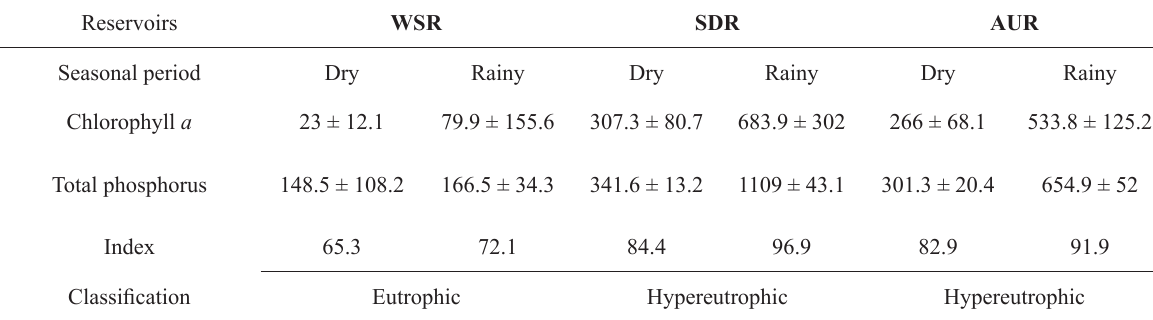
Index of the trophic state, regarding the values of chlorophyll a and total phosphorus, in a tropical semiarid basin (Pajeú river). The classification is based on Carlson (1977) modified by Toledo Júnior (1990). (mean ± standard deviation). WSR = water supply reservoir (Cachoeira II), SDR = sewage discharge reservoir (Borborema) and AUR =